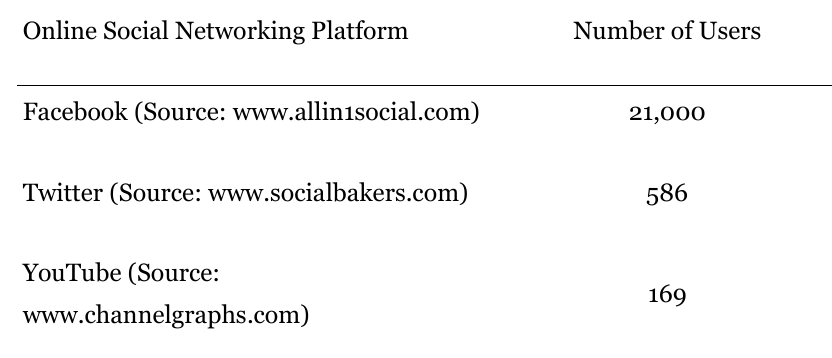
Usage of Online Social Networking Platforms in the Kingdom of Tonga as of June 2014